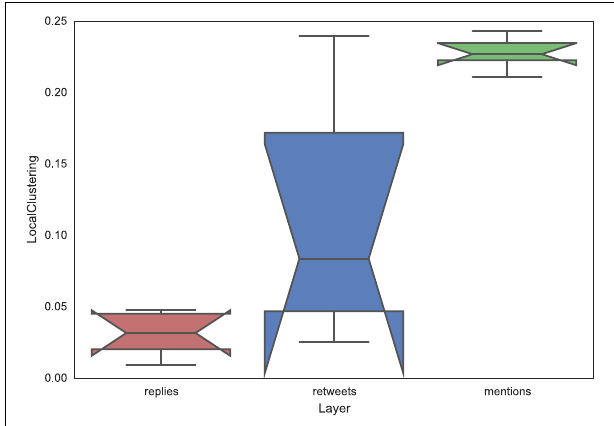
FIGURE 7 | Notched box plots showing the value of the average clustering coefficient for each layer. Each box aggregates the values corresponding to the different events